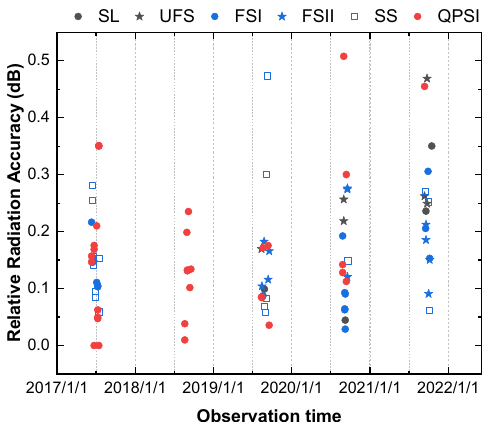
Figure 9. GaoFen-3’s relative radiation correction accuracy evaluation using the Inner Mongolia datasets from June 2017 to October 2021. The estimation of each scatter is based on the CR responses in a single image.